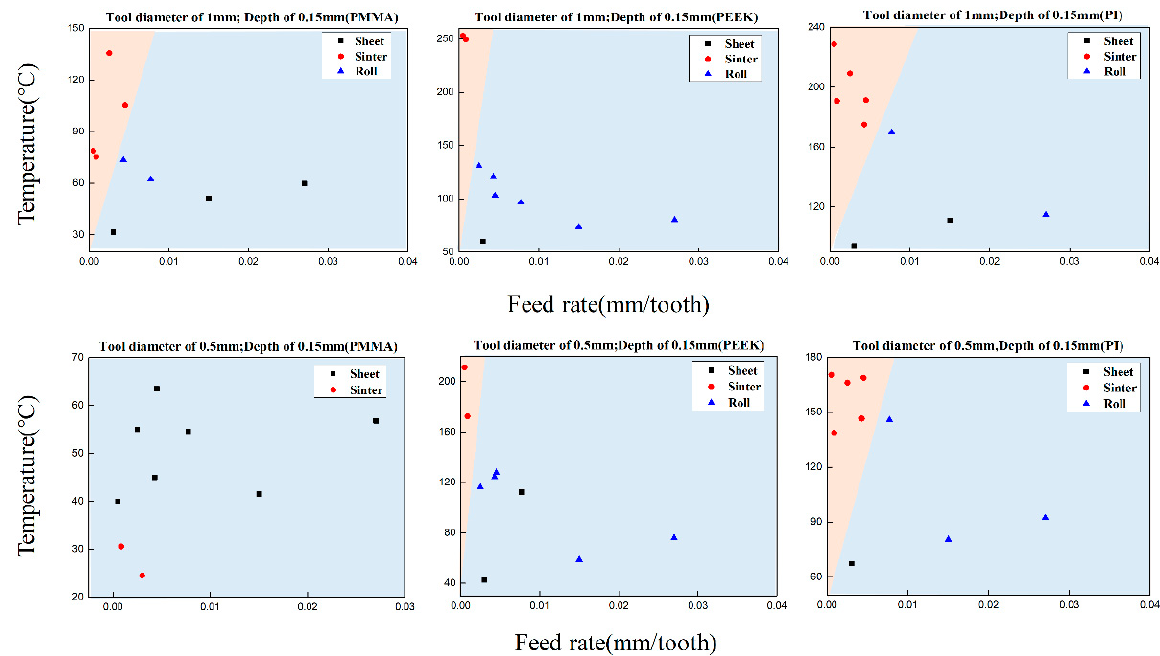
Figure 10. PMMA, PEEK, PI chip distribution with temperature and feed rate.